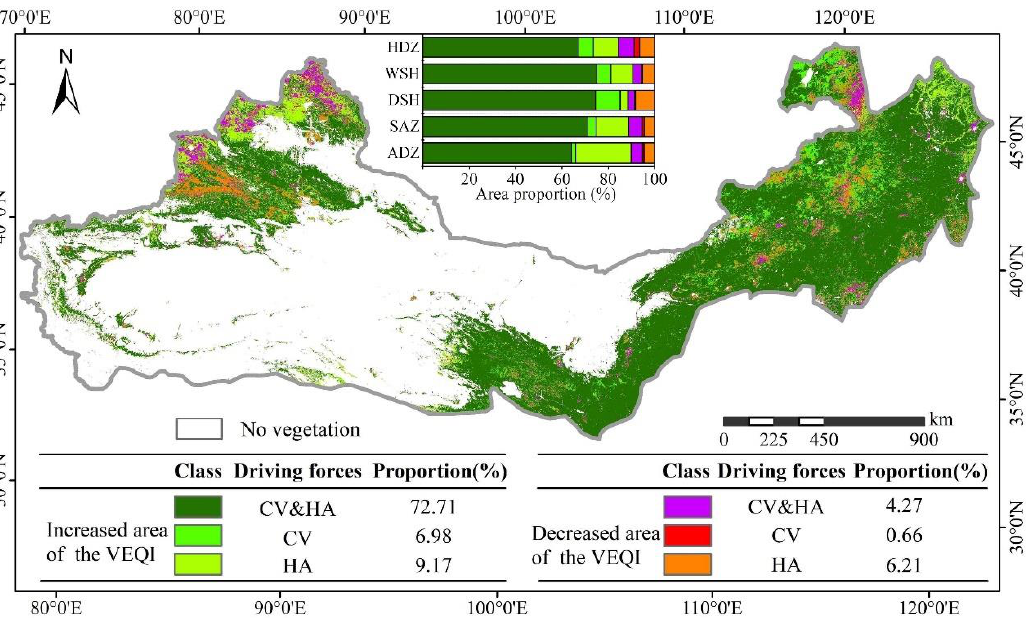
Figure 12. Spatial distribution characteristics of the drivers of VEQI changes in the TNS from 2000 to 2020.